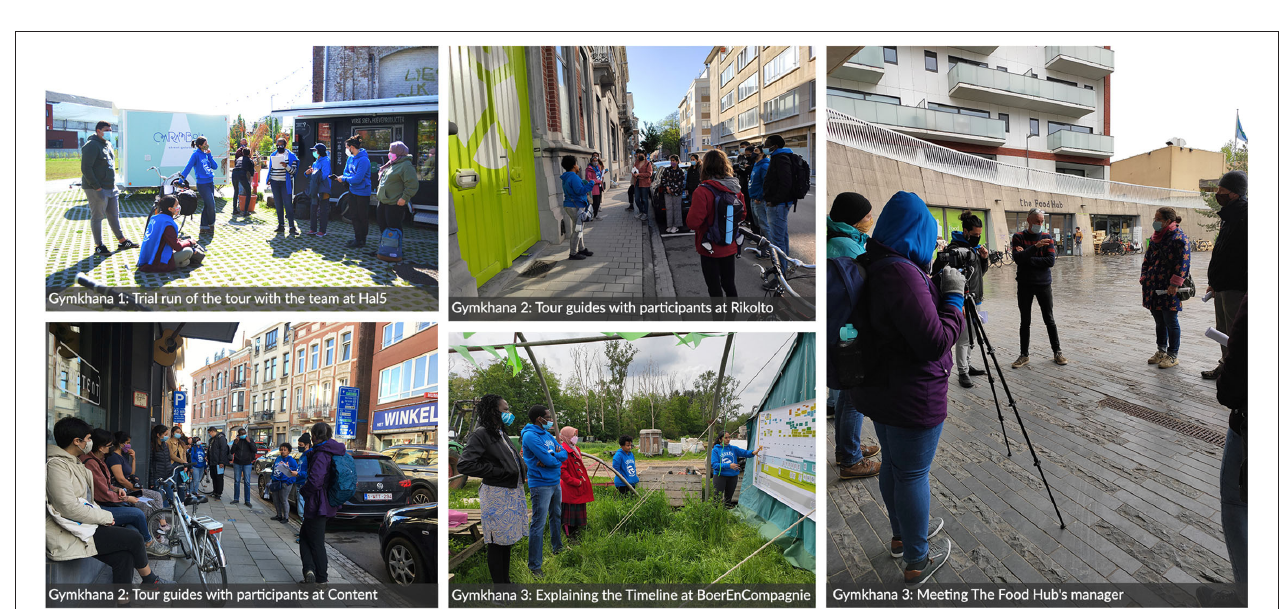
FIGURE 9 | Summary of LeuvenGymkhana 2.0 tours and their itineraries as shown in the leaflet.